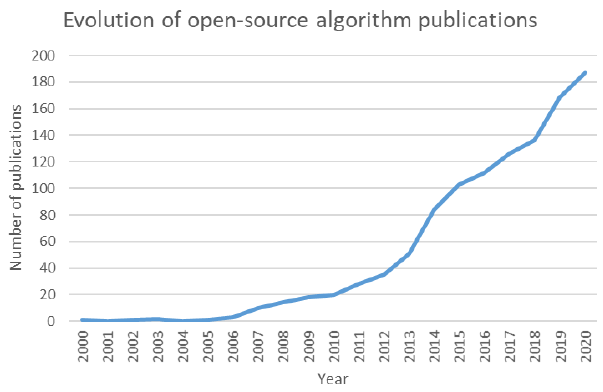
Figure 1. Evolution of yearly open-source algorithm publications between 2000 and 2020; data from Web Of Knowledge (last access: 1 September